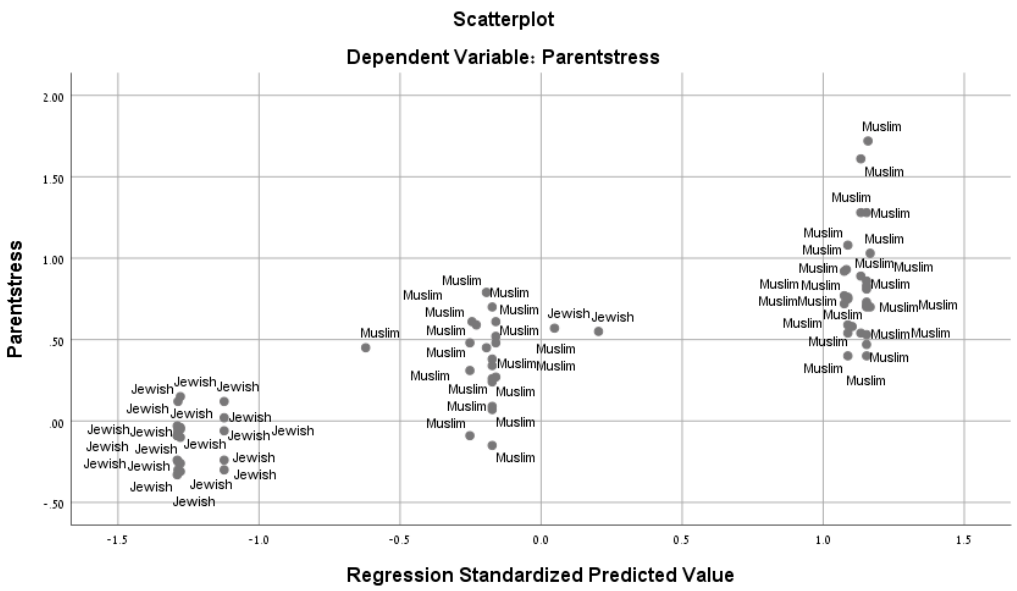
Figure 2. Scatter plot of Muslim and Jewish mothers by maternal stress.